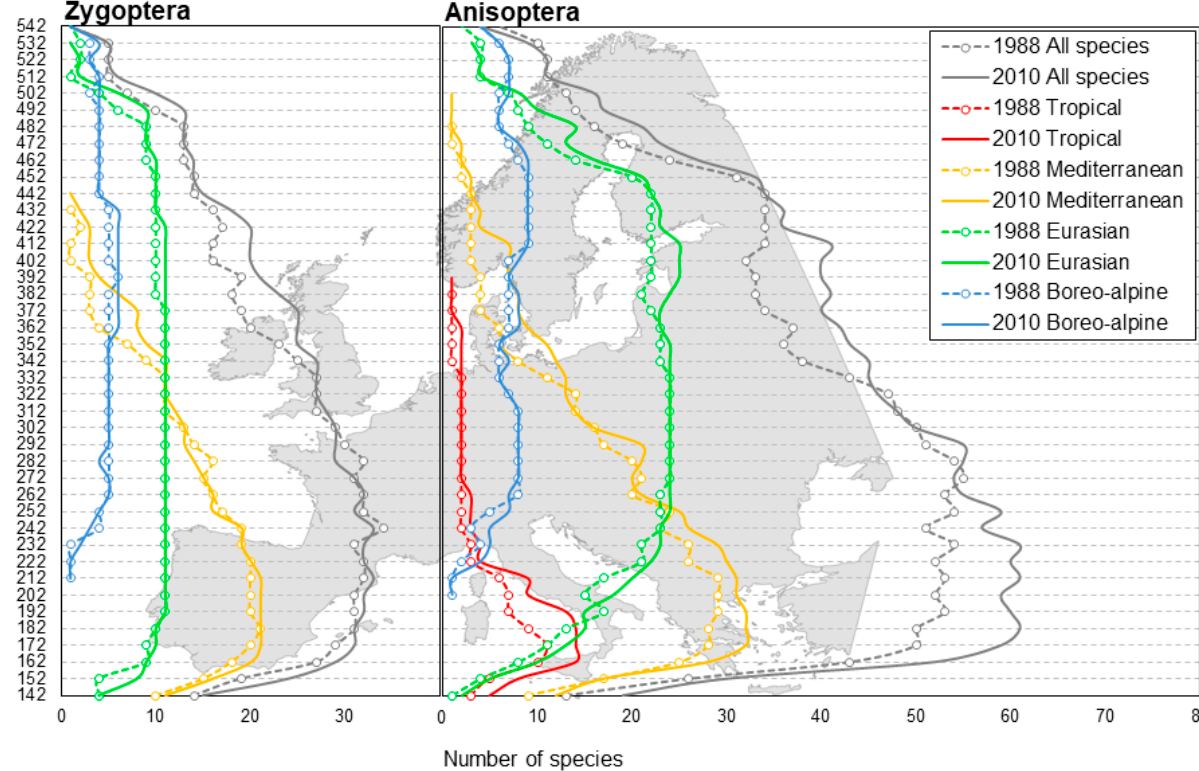
Figure 3. Shift in latitudinal species richness of European dragonfly (Odonata) species, plotted against latitude. Species richness presented as number of species in 100-km latitudinal intervals in species from 1988 to 2010. Data separated by biogeographical groups (Tropical— red , Mediterranean— yellow , Eurasian— green , and Boreo-alpine— blue ) for damselflies (Zygoptera, left ) and true dragonflies (Anisoptera, right ).